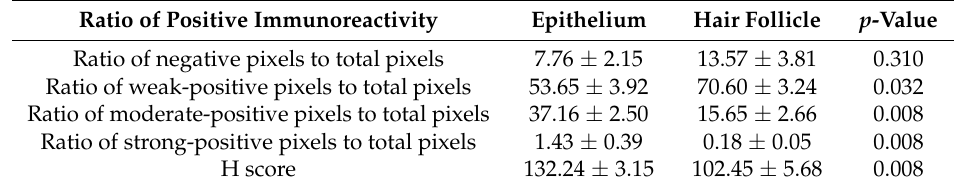
Table 1. Erdr1 expression in a healthy